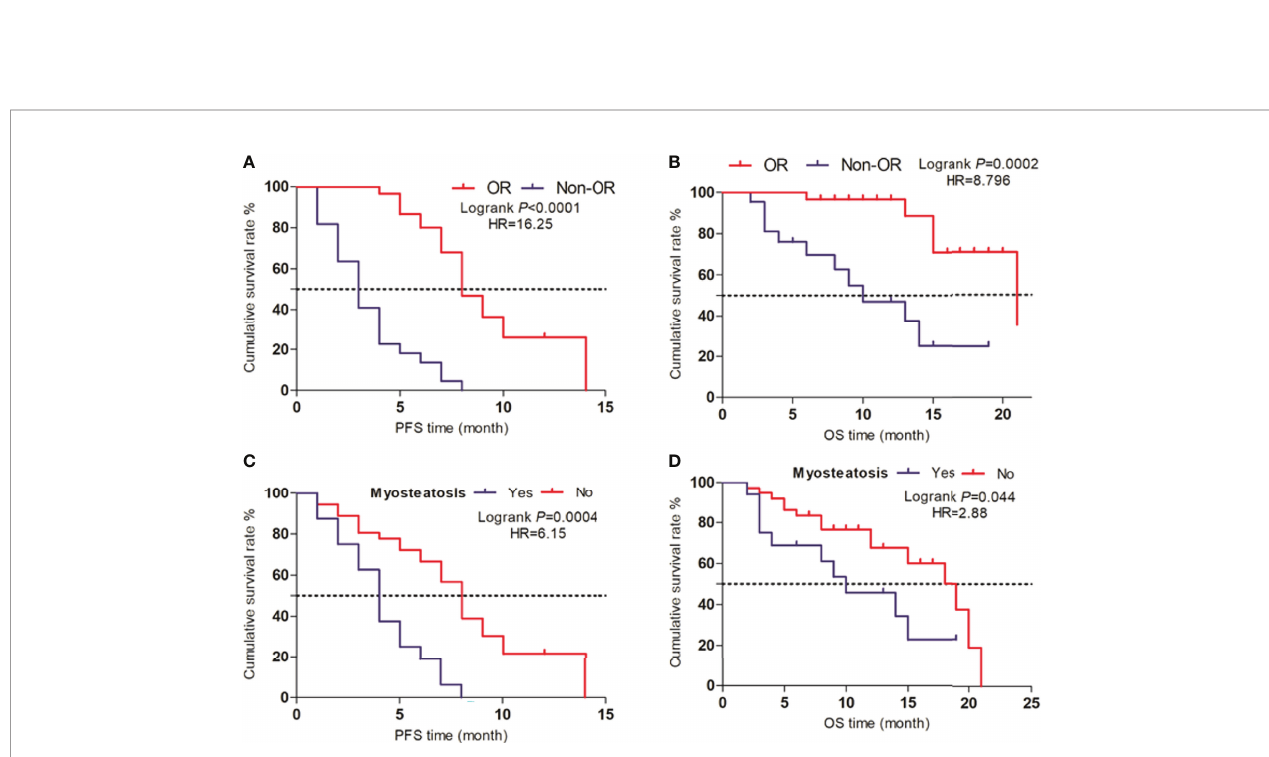
FIGURE 5 | Survival analysis (A, B) Life curves showing the PFS and OS time periods between the OR and Non-OR groups. (C, D) Life curves showing the PFS and OS time periods between patients with myosteatosis and